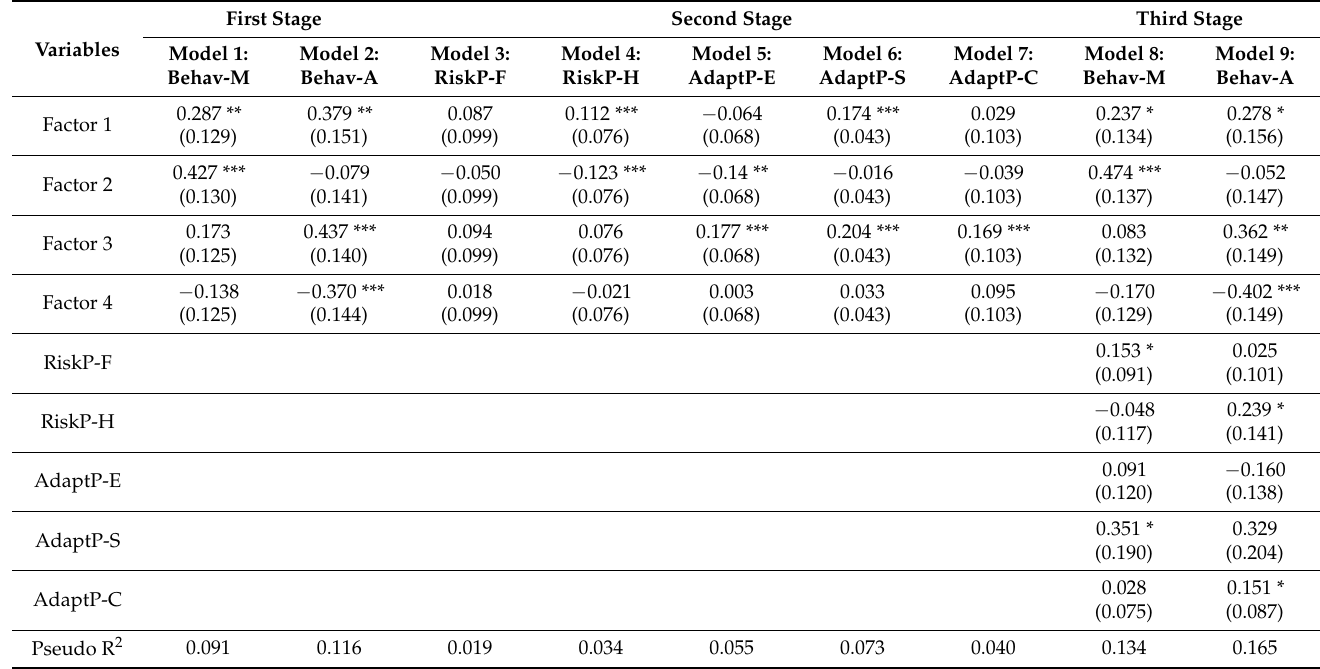
Table 4. The mediating effect of perceptions between characteristics and